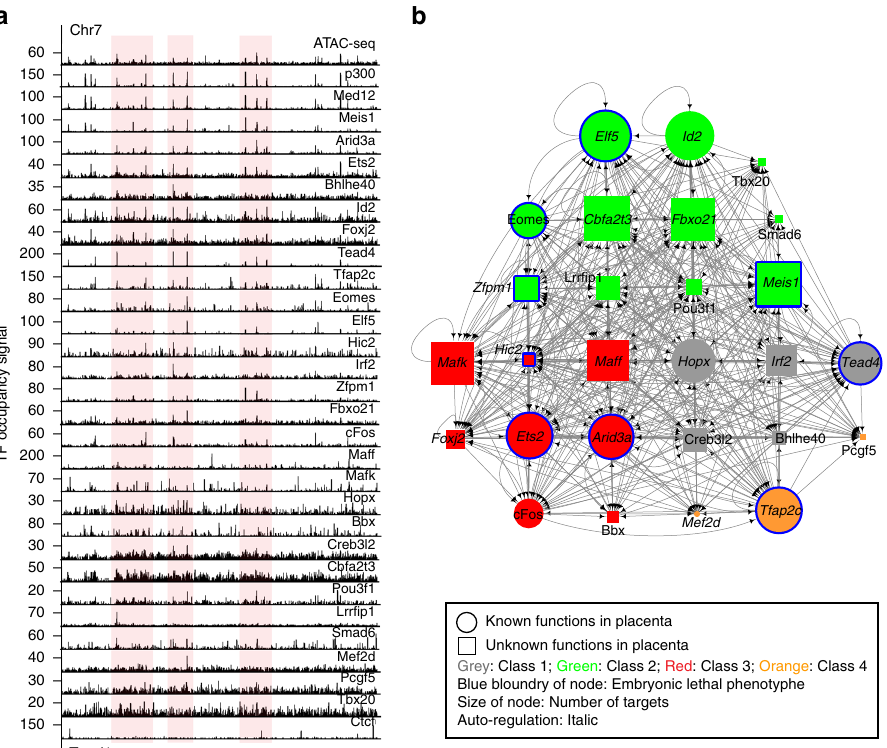
Fig. 3 TSC-speci fi c transcriptional gene regulatory network. a Snapshots of multiple ChIP-seq signal tracks of TFs near Tead1. b A transcriptional regulatory network of TSC-speci fi c TFs. TFs having known and unknown functions in TSCs are shown as different shapes (round for known, rectangular for unknown). Classes de fi ned by the expression pattern of a TF during TSC differentiation (Fig. 2a) are shown with different color code. Genes showing a lethal phenotype of embryo upon deletion are shown with blue boundary. TFs showing auto-regulation are shown with